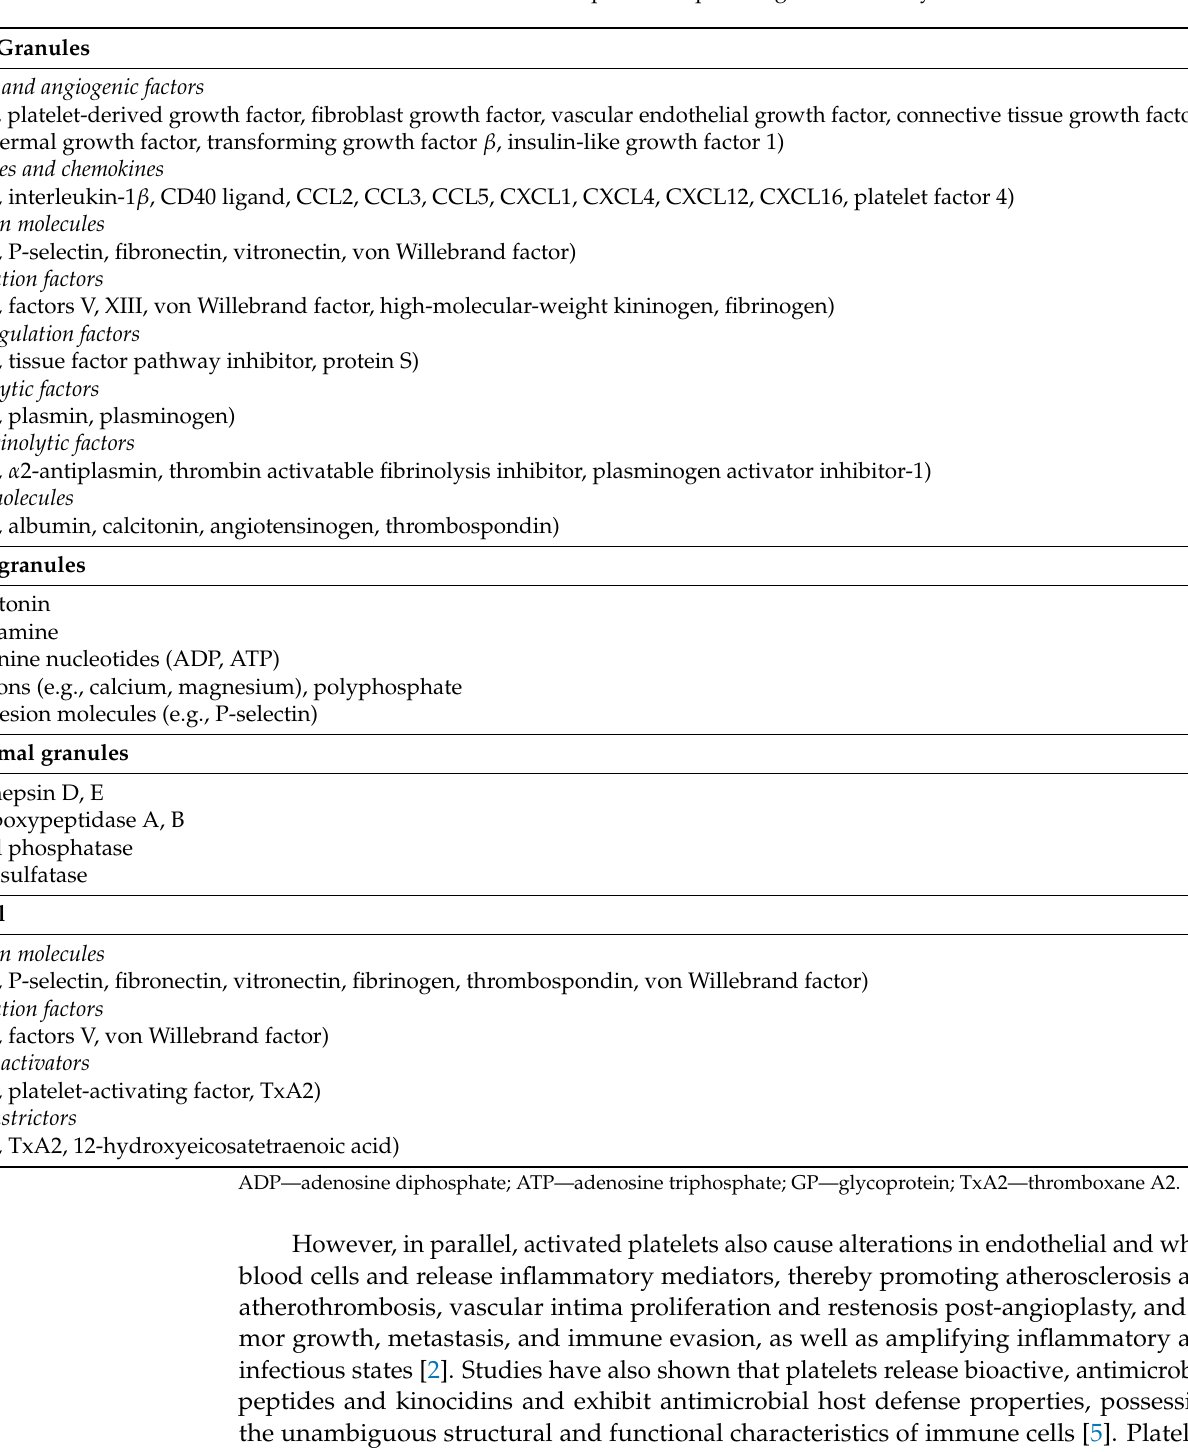
Table 1. Main classes of substances present in platelet granules and